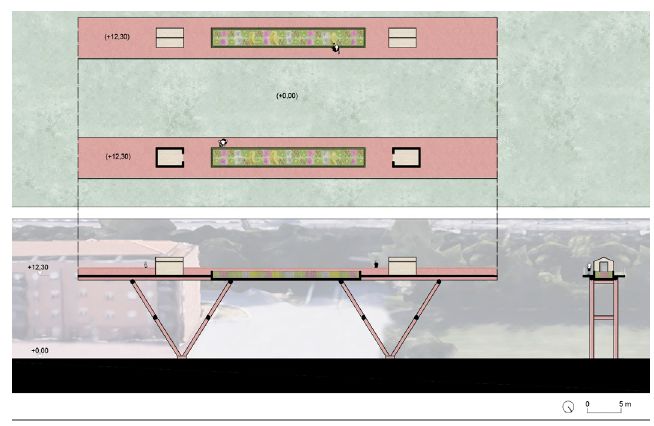
Fig. 4 Belardi, P., Battistoni,